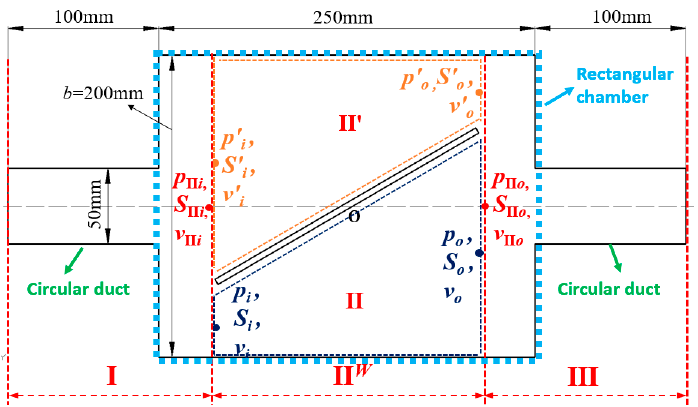
Table 1. Description of each component of the REC with one baffle.